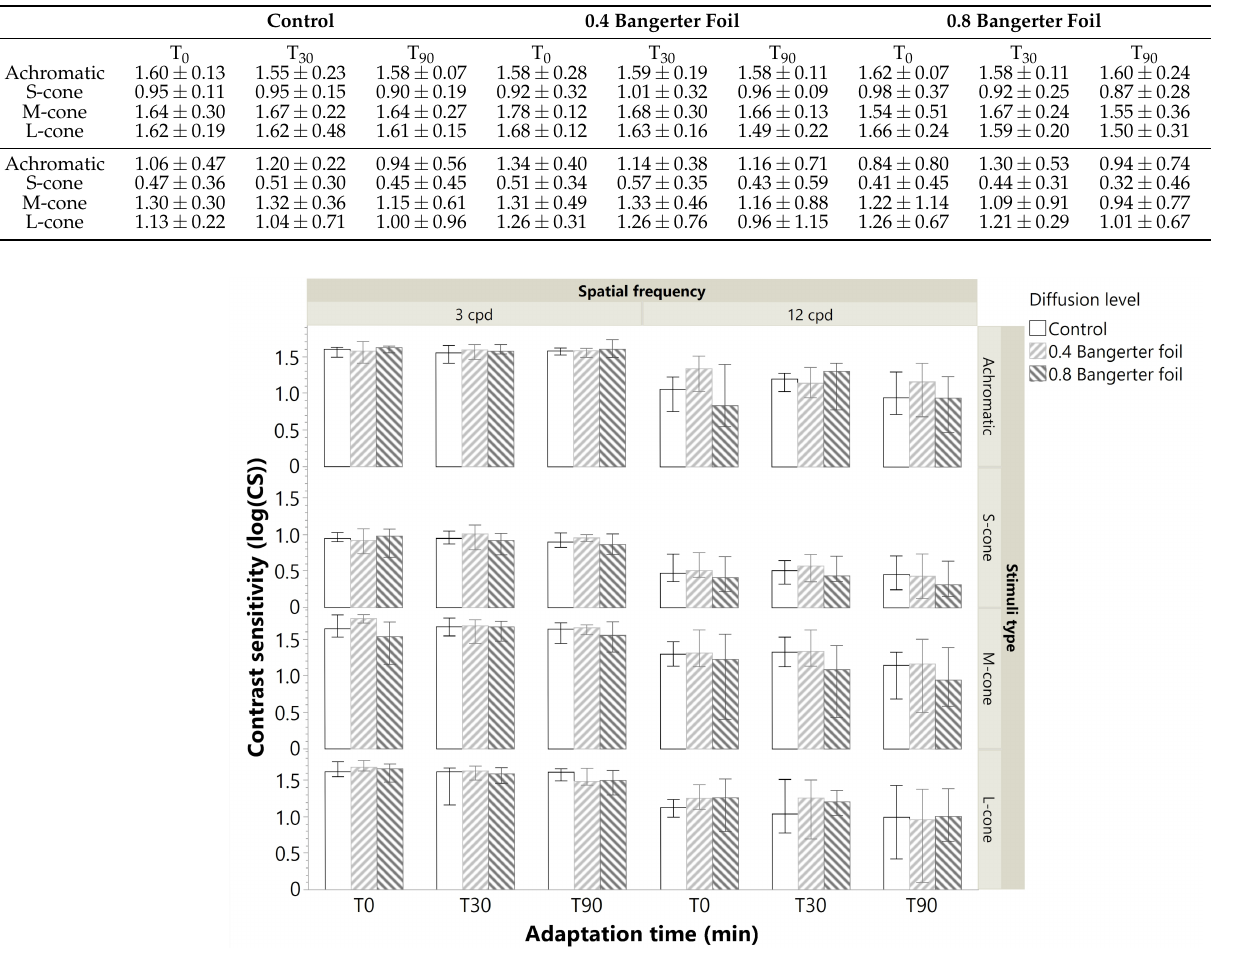
Figure 4. Median ± IQR in log(CS) for the different diffusion levels, spatial frequencies, stimuli types, and adaptation times ( n =19